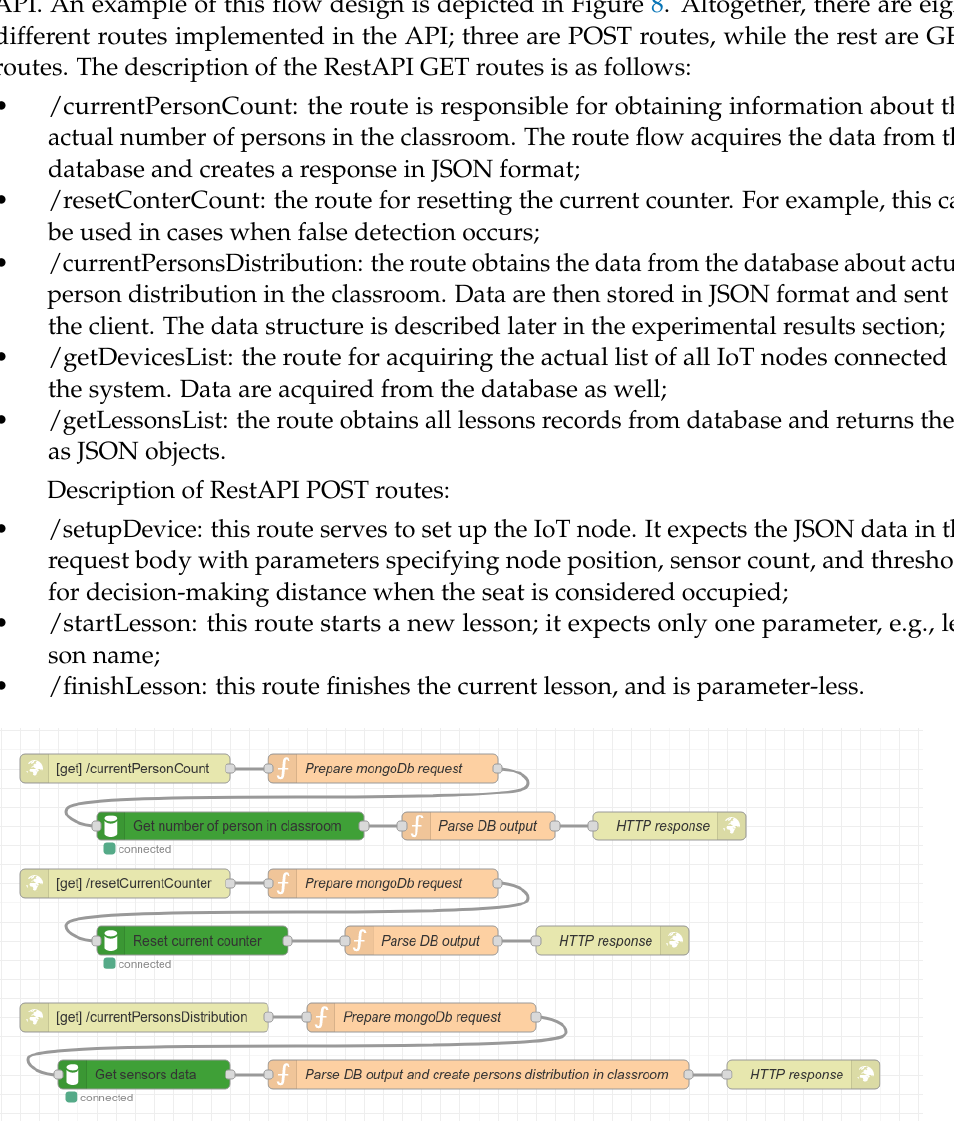
Figure 8. Schematic design of flow for providing the RESTful